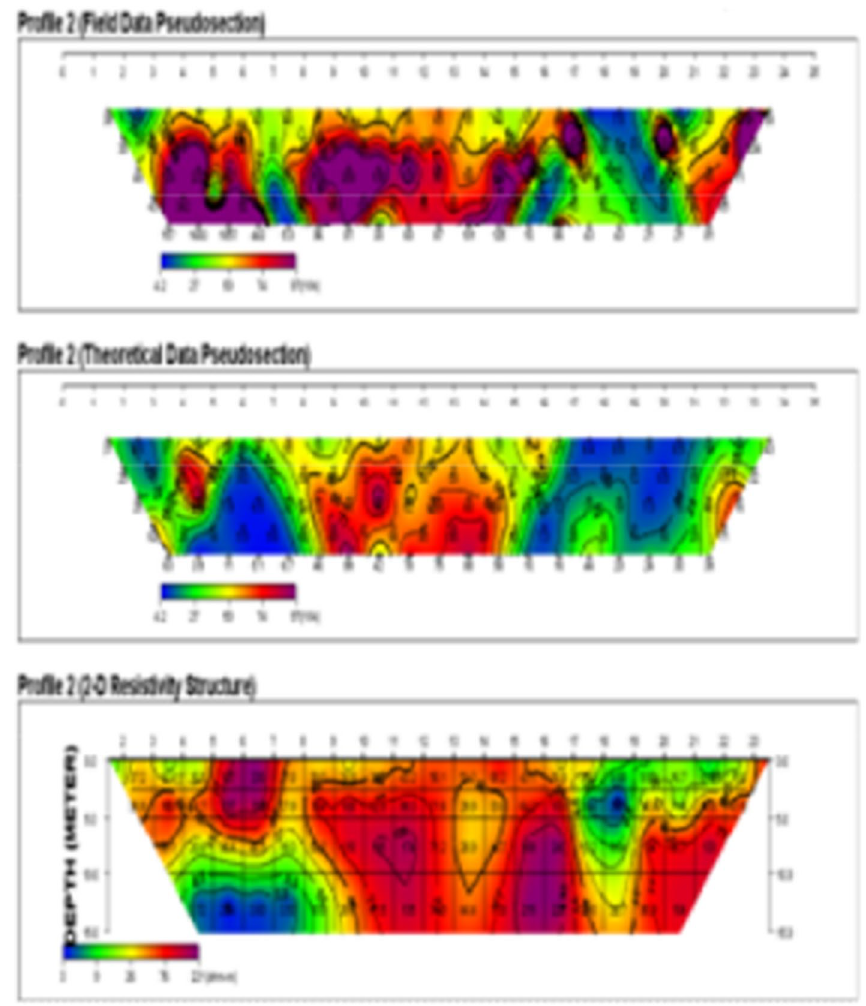
Fig. 3 2-D Resistivity Structure and Geoelectric Section along a Traverse, Bayode et al.